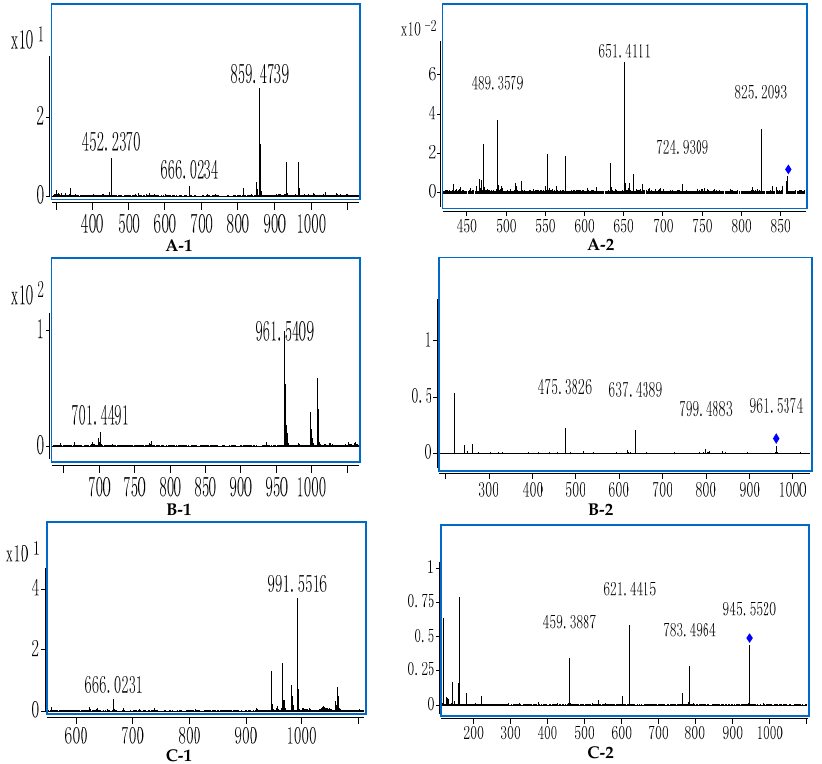
Figure 6. The typical TOF-MS spectra of compounds 18 ( A ); 25 ( B ); 92 ( C ) in negative mode (1: MS spectra; 2: MS/MS spectra).